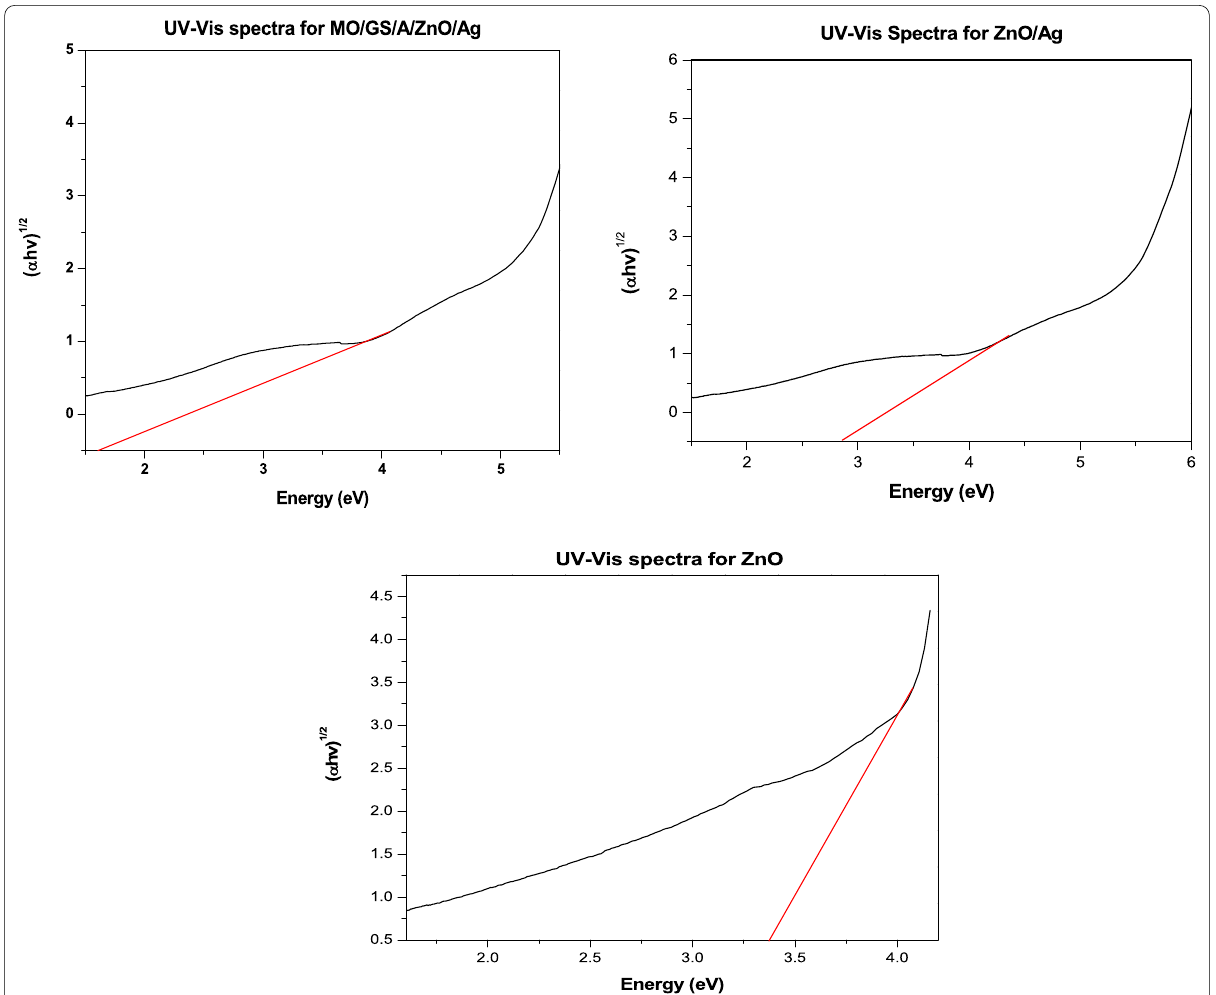
Fig. 2 Optical absorption spectra of the synthesized samples MO/GS/A/ZnO/AG, ZnO/Ag and